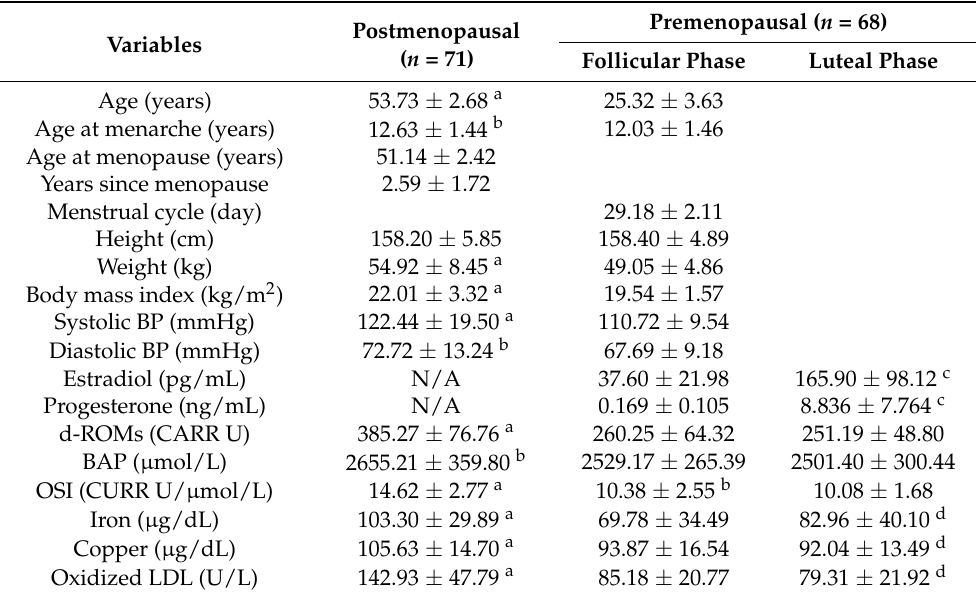
Table 1. Characteristics and biochemical parameters of the postmenopausal and premenopausal women.